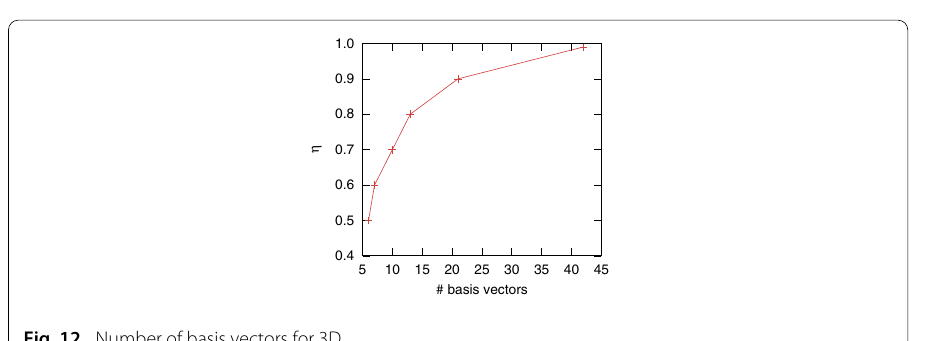
Fig. 12 Number of basis vectors for